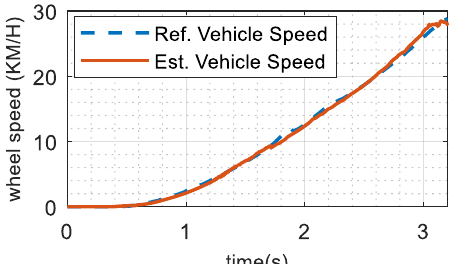
Figure 11. Controller-estimated speed and reference vehicle speed from the production vehicle.